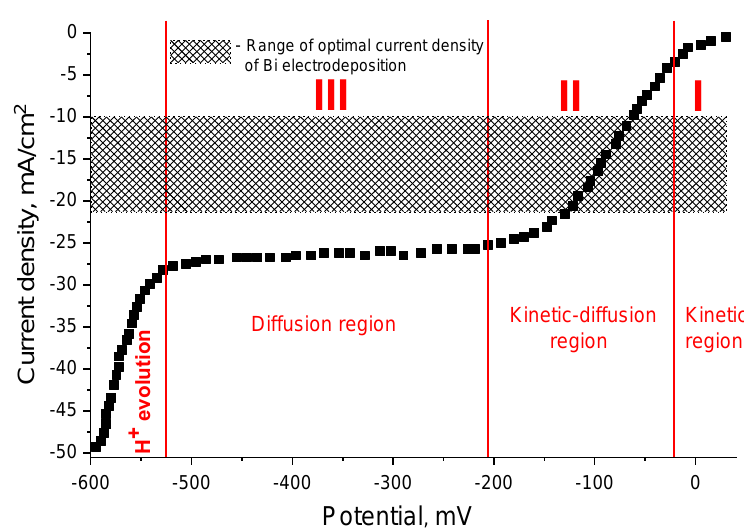
Figure 1. The polarization curve of the Bi electrodeposition from perchlorate electrolyte (PE) without mixing. Three main regions can be observed on the polarization curve that describes the electrochemical and di ff usion kinetics of the electrodeposition process (Figure 1). Initially, at small deviations of the potential from zero, the deposition of Bi proceeds in the kinetic regime (region I of Figure 1). In this case, as the cathodic polarization increases, the reaction rate rises, and the di ff usion begins to slow it down without supplying a su ffi cient number of ions to the electrode surface per unit time. A region of mixed kinetic-di ff usion processes arises (region II in Figure 1). This inhibition is more